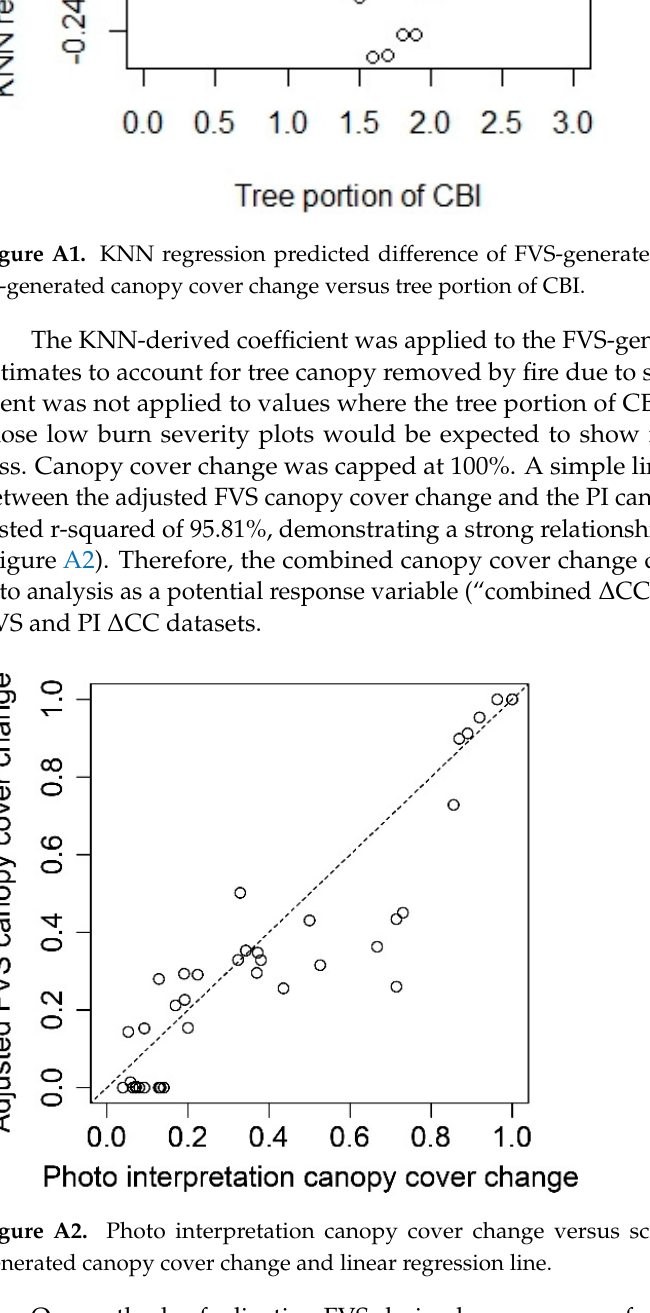
ated canopy cover change and linear regression line.